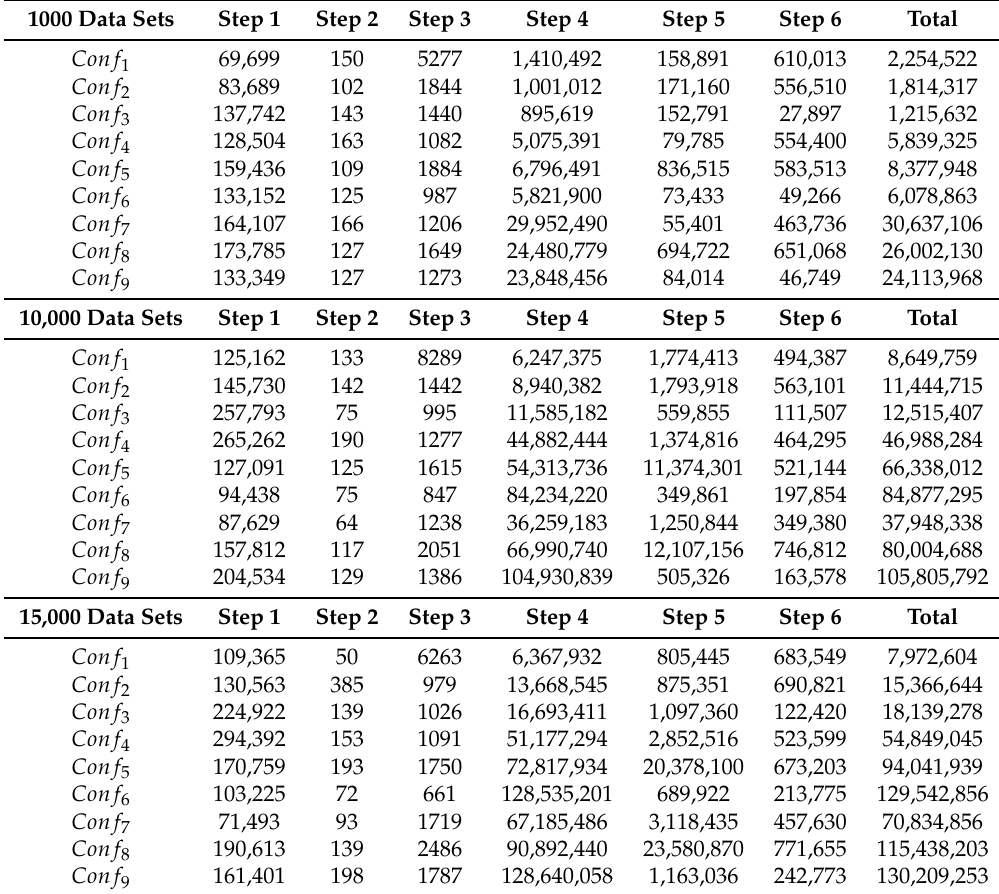
Table 4. Execution times for the corpora of 1000–10,000–15,000 data sets for version without Map-Reduce of the